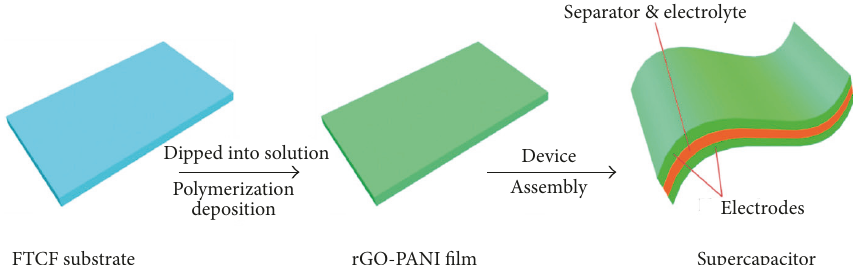
Figure 4: Preparation of nanocomposite coating via in situ polymerization method